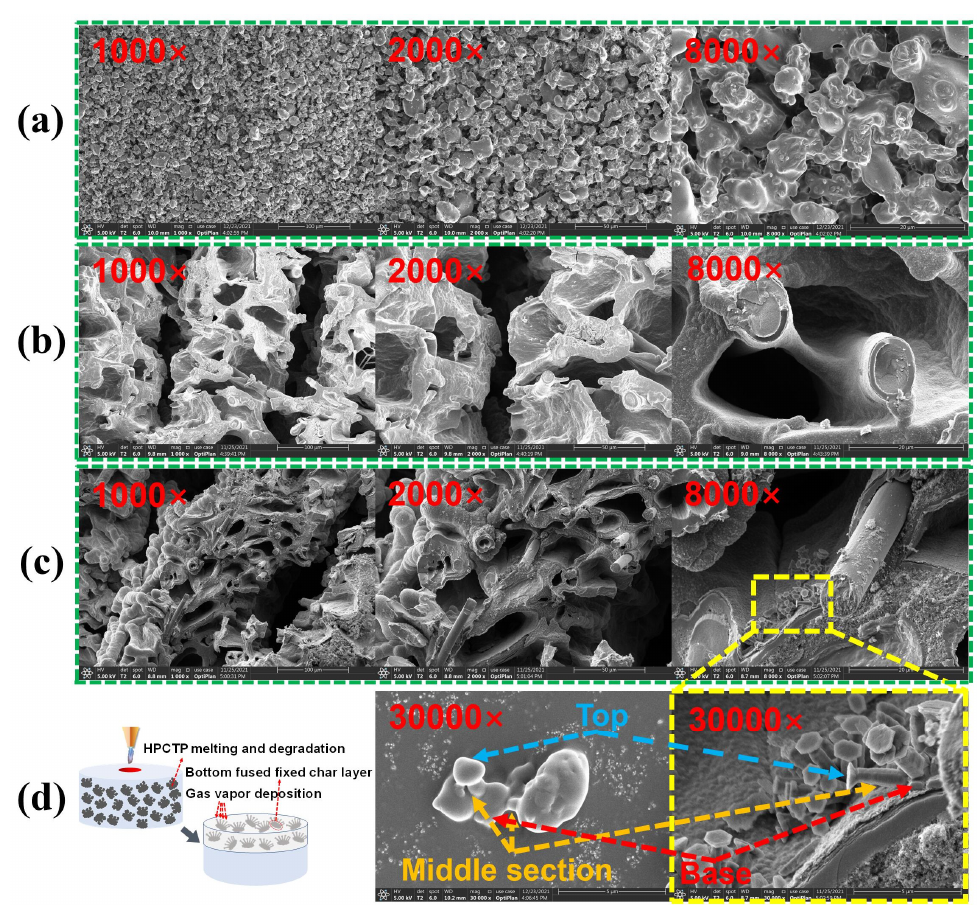
Figure 7. Morphology of the char layer at different magnifications: ( a ) HPCTP; ( b ) HPTCP-0; ( c ) HPTCP-15; ( d ) schematic diagram of the formation of phosphate crystal structure.